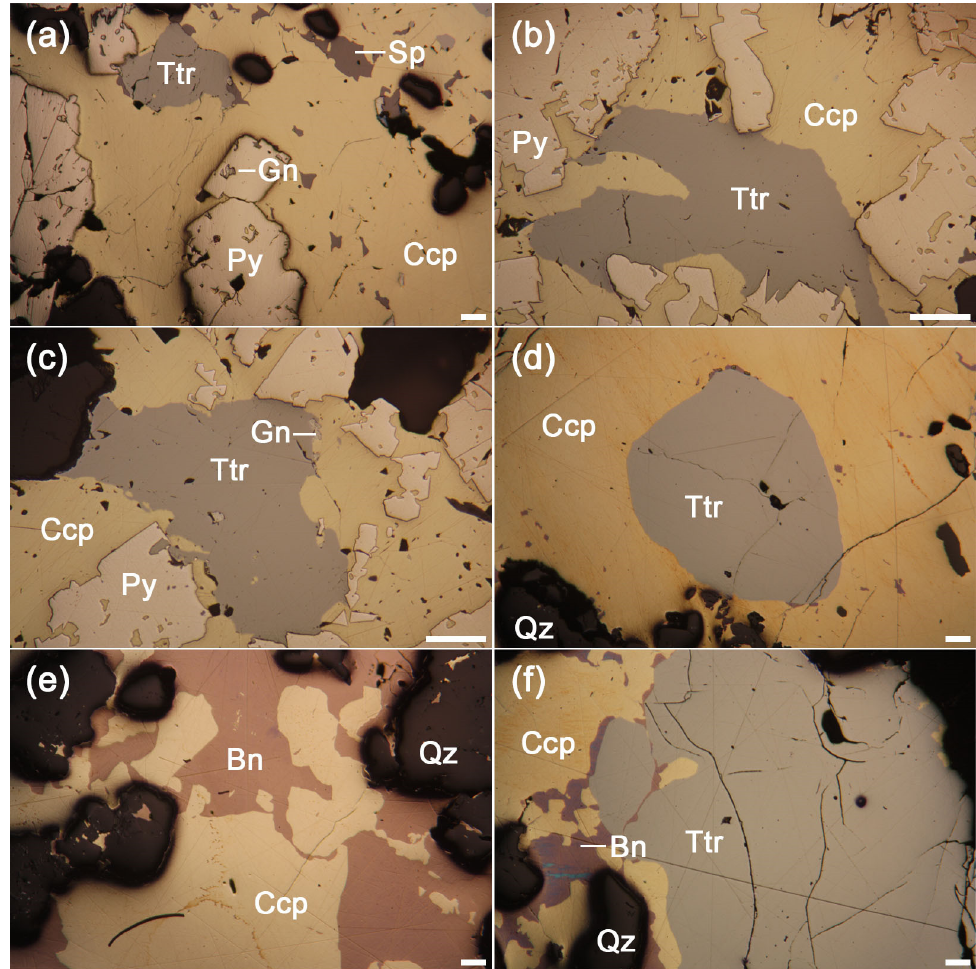
Figure 6. Plane-polarized reflected light photomicrographs of representative copper mineral assemblages: pyrite copper with anhedral and euhedral pyrite cemented and corroded by chalcopyrite; chalcopyrite filling of pyrite pore space ( a – c ); anhedral grains of tetrahedrite included in chalcopyrite ( b – d ); quartz-precompact copper with an intergrowth chalcopyrite, bornite, and tetrahedrite, arranged in the free spaces between the quartz ( e , f ). Sp—sphalerite; Py—pyrite; Ccp—chalcopyrite; Gn—galena; Ttr—tetrahedrite; Qz—quartz; Bn—bornite. Scale bars on the photomicrographs are 100 µ